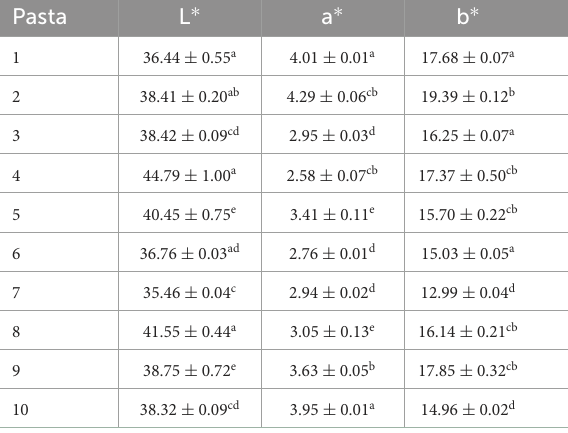
TABLE 4 Colorimetry parameters in extruded pasta based on hyper-protein quinoa. Pasta